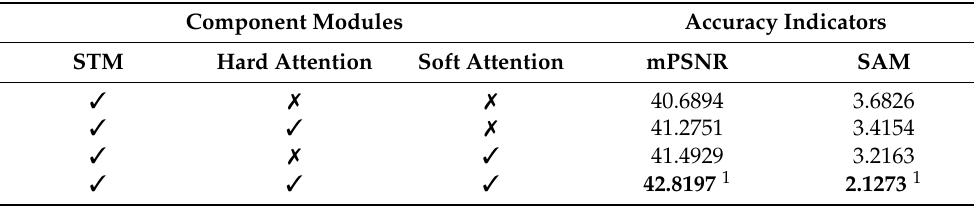
Table 1. Ablation study on the Pavia University data